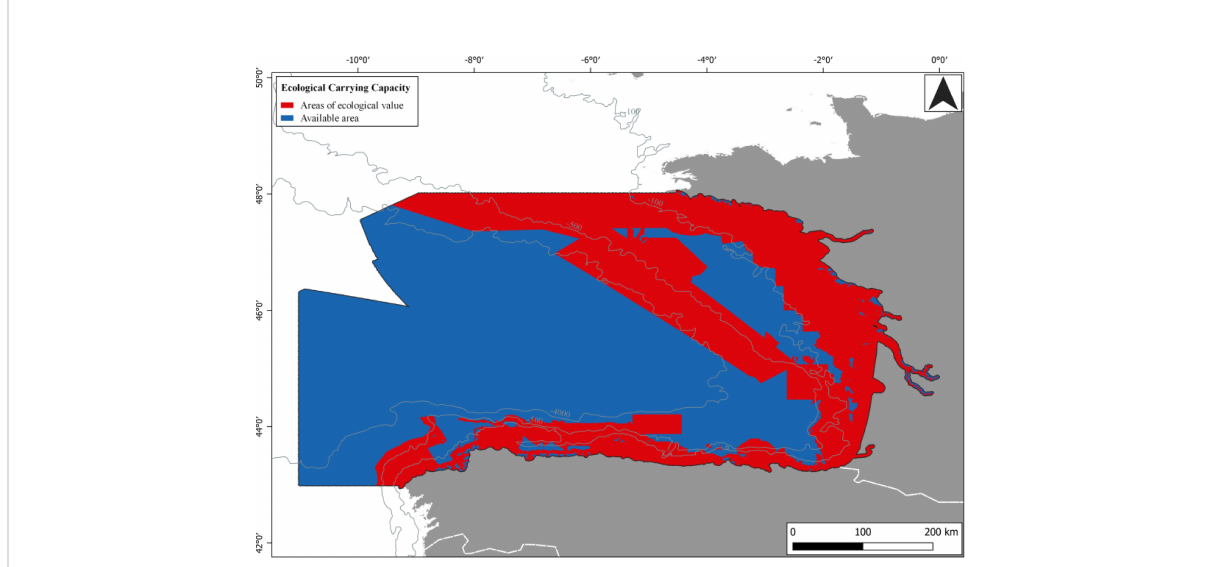
FIGURE 7 Marine Resource-Environment Carrying Capacity (in blue) within the Bay of Biscay. Areas where Marine Protected Areas are present and/or areas with high ecological importance are considered “ areas of ecological value) (in